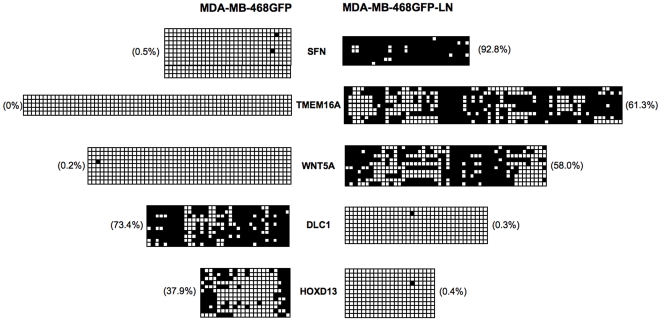
Sodium bisulfite sequencing, gene expression and copy number.Sodium bisulfite sequencing of representative genes detected with aberrant methylation with (or without) a concomitant change in copy number. Each square represents a CpG (open square: unmethylated; closed square: methylated). Each row of squares one cloned PCR sequence across the gene promoter (5–20 clones were sequenced per gene). Percentages indicate degree of methylation at each gene locus.